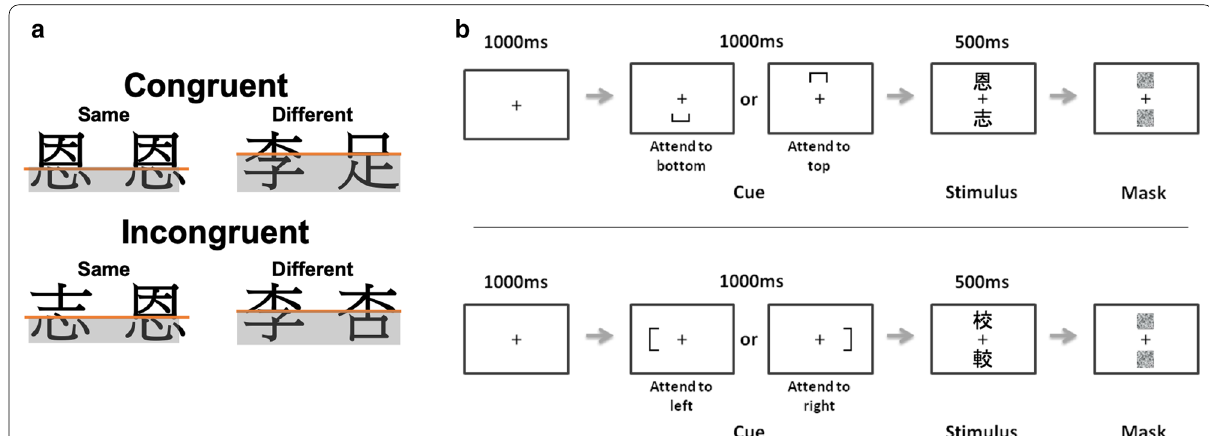
Fig. 3 Illustration of stimulus pairs in the complete composite paradigm and trial sequences. In ( a ), it shows the four conditions used in the paradigm; the attended components are shaded in grey. In ( b ), a 1000 ms central fixation cross precedes each trial, followed by a cue either below or above the cross, or to the left or right of the cross, to indicate which halves (top or bottom/left or right) of the characters participants should attend to in the subsequent display. The complete composite paradigm (Gauthier & Bukach, 2007) was adopted so that in congruent trials, the attended and irrelevant/unattended halves corresponded to the same response (i.e. both were the same or both were different); by contrast, in incongruent trials, the attended and irrelevant/unattended halves would correspond to different judgments (e.g. the top halves were the same, while the bottom halves were different). We adopted this paradigm to avoid response biases that may occur in the partial composite design where the irrelevant/unattended halves are always different (Richler et al., 2011; Robbins & McKone,